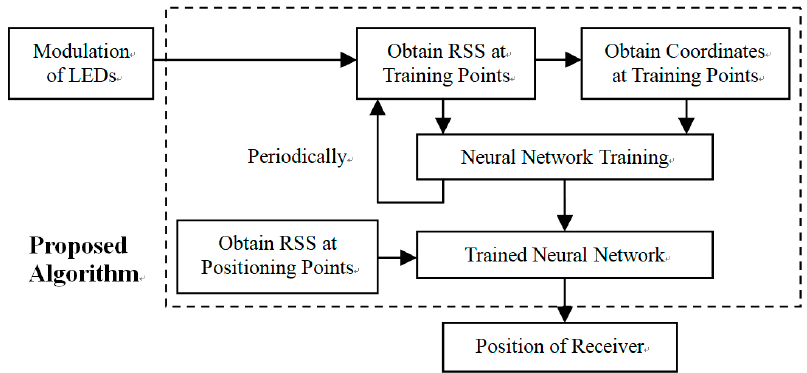
Figure 3. Flow chart of proposed Modified Momentum Back-Propagation (MMBP) algorithm.